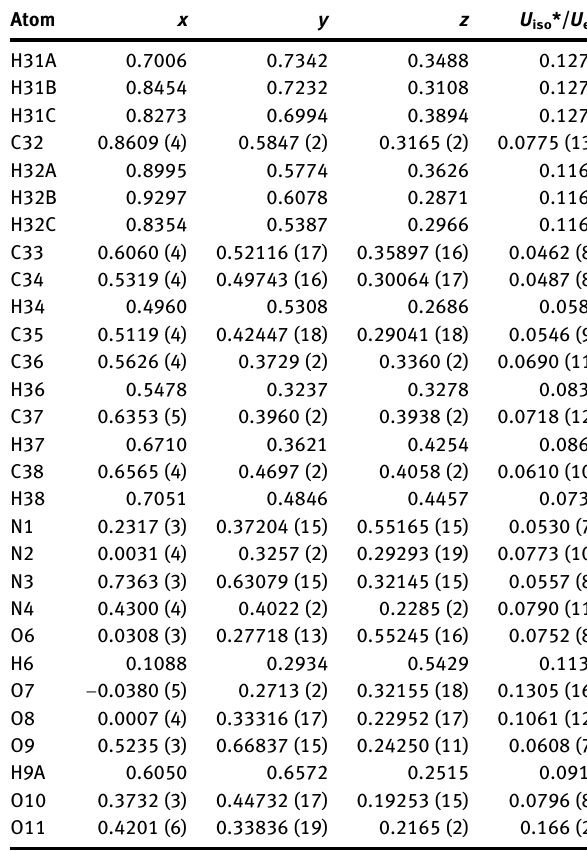
Table  : Fractional atomic coordinates and isotropic or equivalent isotropic displacement parameters (Å 